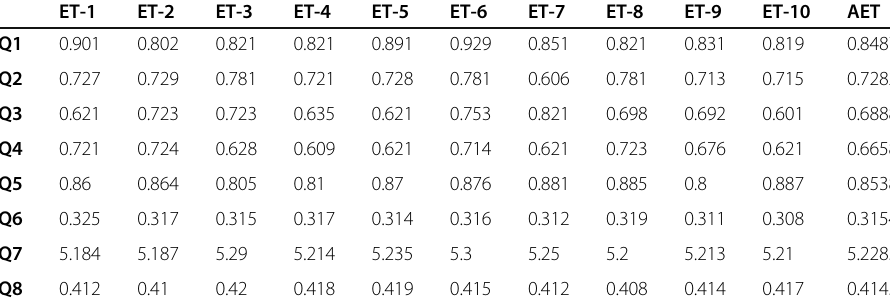
Table 15 Query execution time for Amazon EKS with Washington State data for